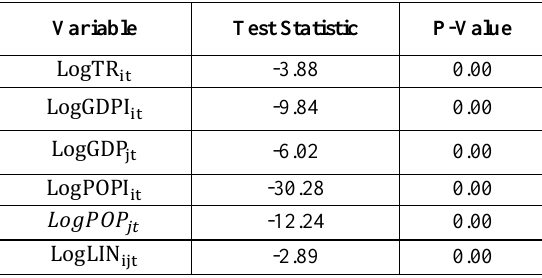
Table 1: LLC Test